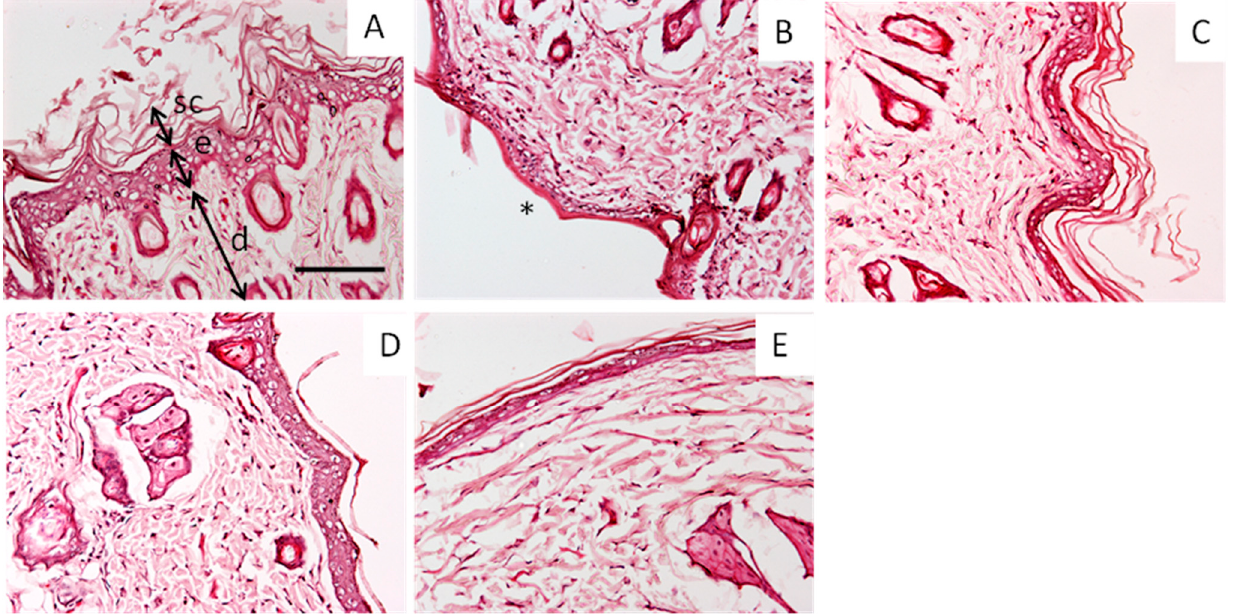
Figure 7. Representative histological sections (magnification 200x) of rat skin stained with haematoxylin and eosin in ( A ) control conditions (ethanol) and ( B ) upon treatment with xylol (Control+), or treated with xylol and ethanolic solution of ( C ) CAT, ( D ) CUR or ( E ) BDMC. Skin structures: sc, stratum corneum; e, epidermis; d, dermis; * indicates the loss of stratum corneum. Scale bar = 100 µm.